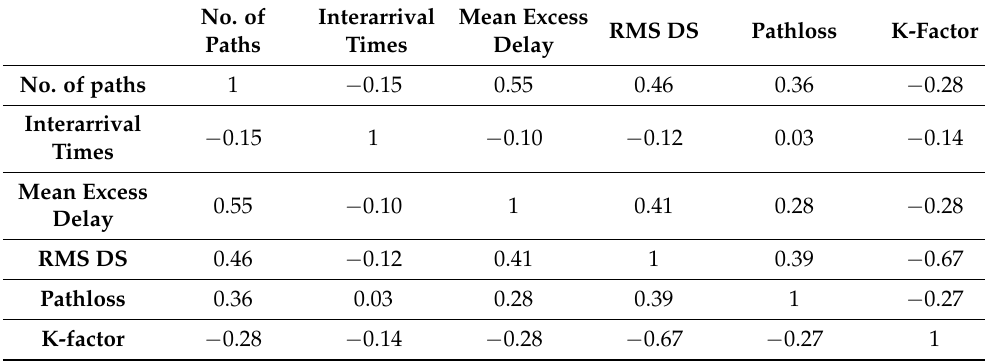
Table 7. Correlation